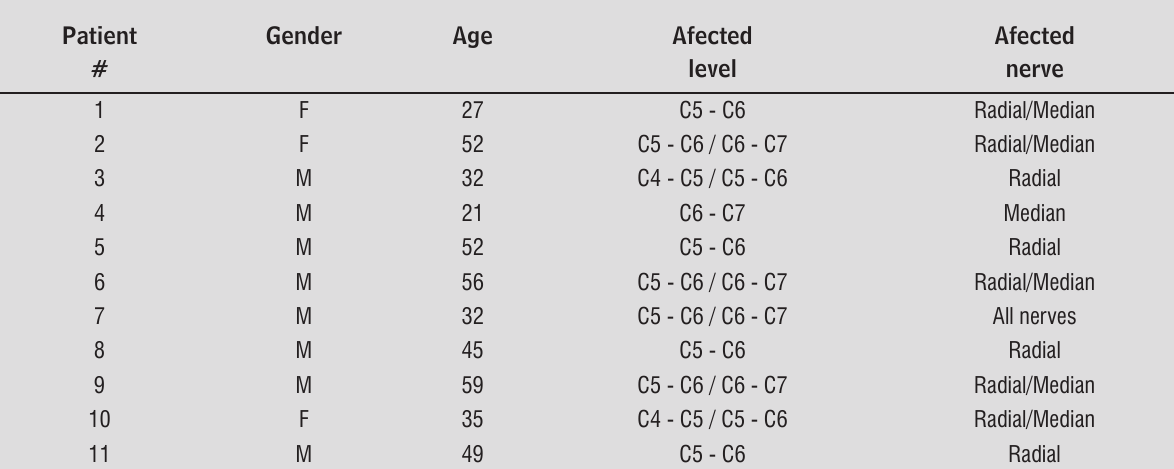
Table 1 - Demographic and clinical data of patients included in the